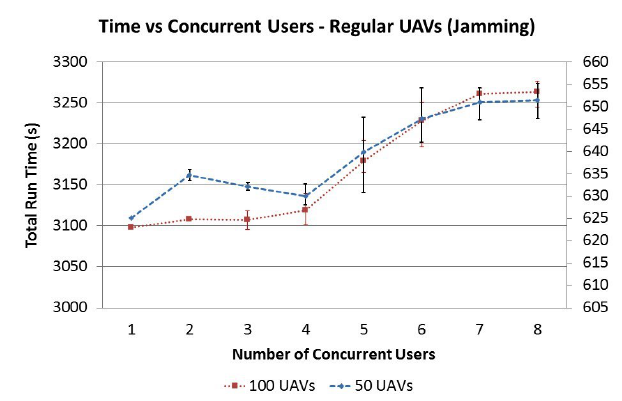
Figure 11. Run time variation of security simulation with increasing number of concurrent users in server mode operation for Jamming